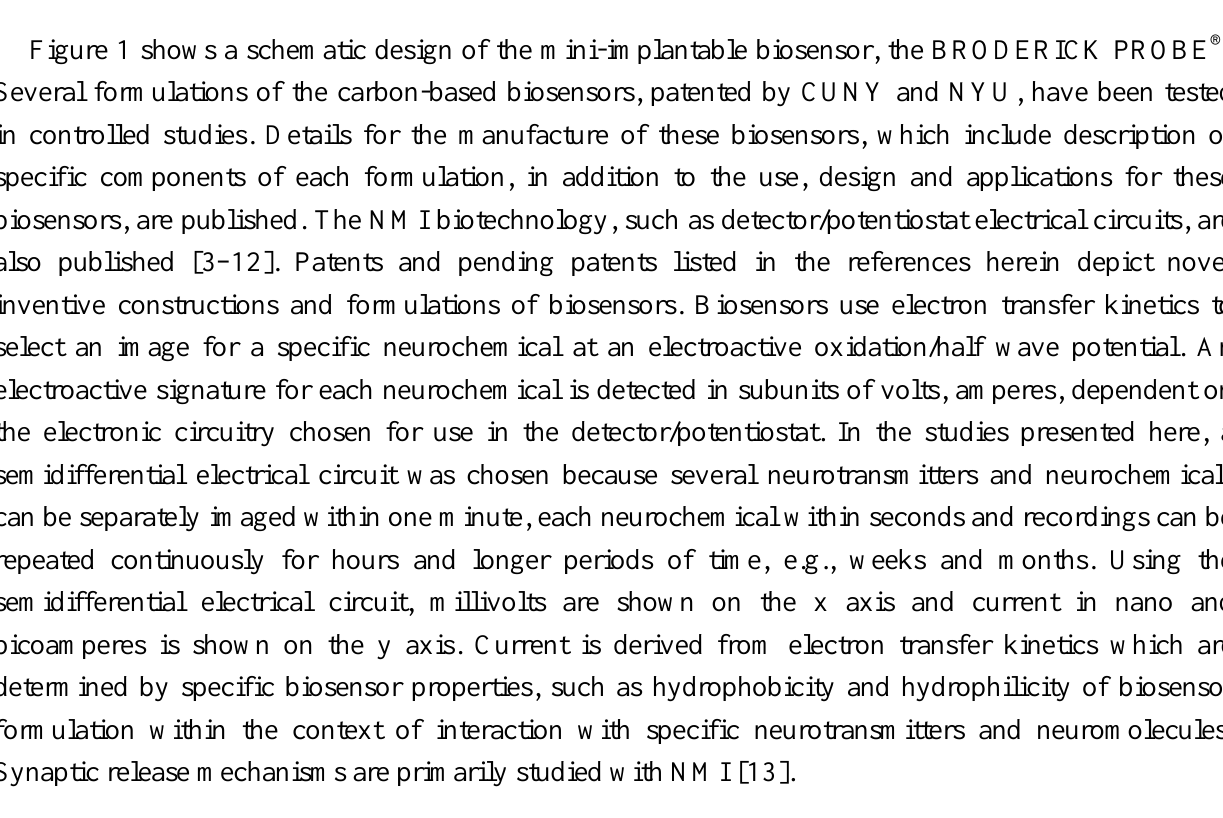
Figure 1. A schematic diagram of the BRODERICK PROBE ® biosensor. Some of the formulations are comprised of fatty acids and lipids, normal constituents of